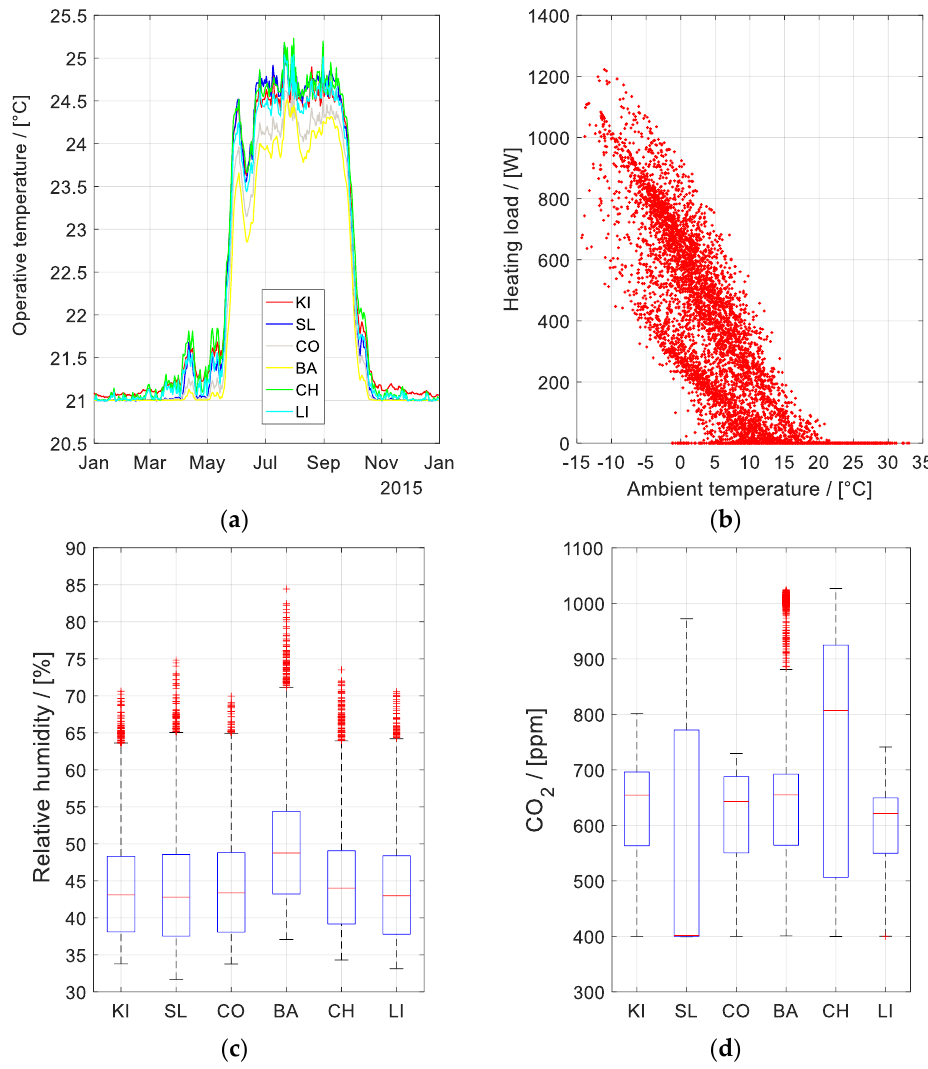
Figure 16. Analysis of reference system (room-wise electric radiator): ( a ) daily average operative temperatures for each room of the flat; ( b ) hourly heating load versus ambient temperature of the flat ( b ) as well as box plot of ( c ) relative humidity and ( d ) CO 2 concentration (CO 2 ambient concentration is 400 ppm) for each room of the flat (KI: Kitchen, SL: Sleeping Room, CO: Corridor; BA: Batch room; CH: child room, LI: Living room).